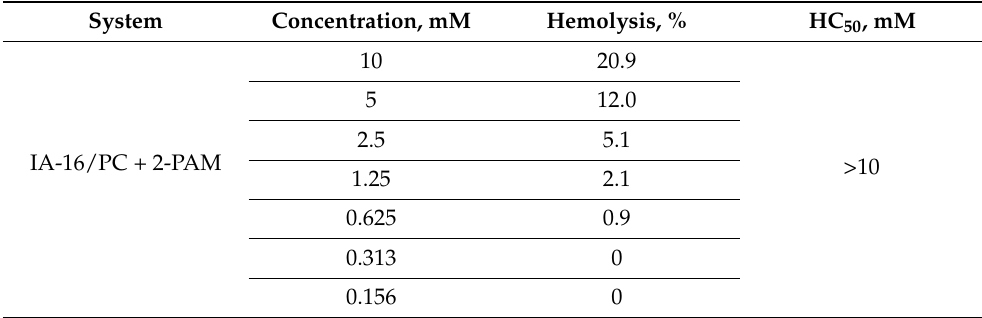
Table 4. Evaluation of the hemolytic activity of IA-16/PC liposomal system (surfactant/lipid molar ratio of 0.029/1) loaded with 2-PAM (C = 10 mg/mL).